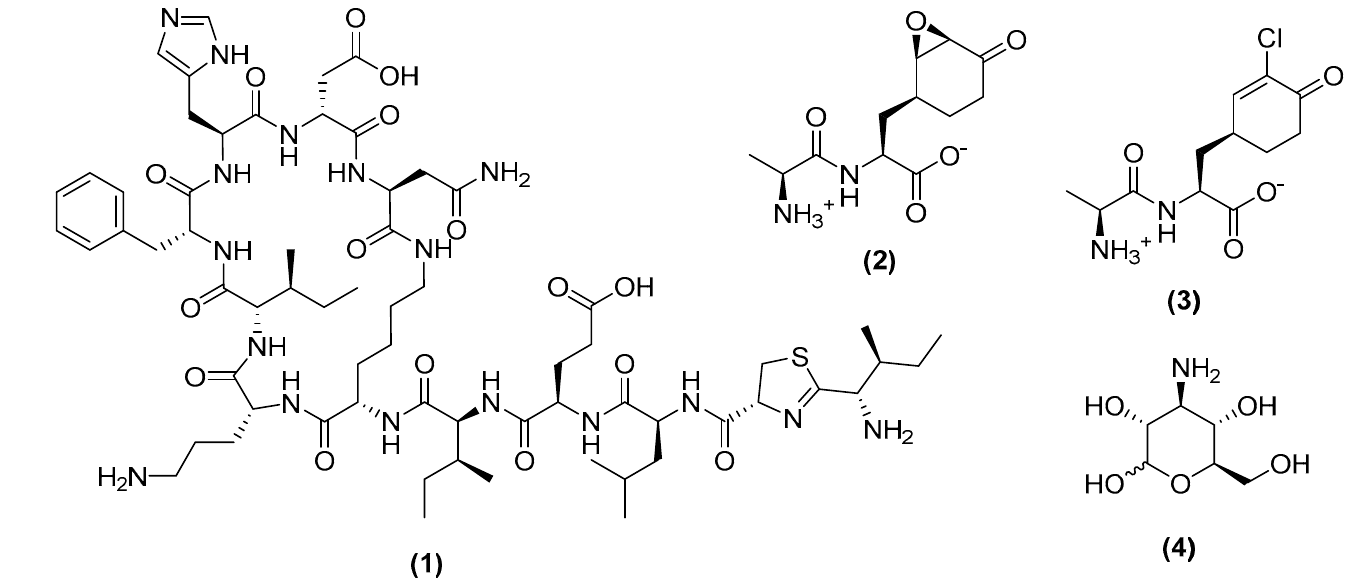
Figure 3. Chemical structures of bacitracin A ( 1 ), bacilysin ( 2 ), chlorotetaine ( 3 ), and kanosamine ( 4 ). Lipid II is a peptidoglycan intermediate, which is formed when the glycosyltransferase MurG catalyzes the addition of N-acetylglucosamine (GlcNAc) to lipid I [25]. Lipid II subse- quently translocates across the plasma membrane, where it transfers MurNaC and GlcNAc to the peptidoglycan layer [26] (Figure 2a). Lipid II is generally conserved throughout microbes and has been studied as a target for various antimicrobial compounds, especially lantibiotics [27]. Lantibiotics are a class of large ribosomal compounds, typically around 3000kDa, and contain unique lanthionine and β -methyllanthionine residues [28]. These lantibiotics are often further divided based on the enzymes involved in their biosynthesis, which includes class I (5, 6) and class II (7, 8, 9) lantibiotics (Figure 4). Subtilin (5) is a class I lantibiotic isolated from B. subtilis 6633 [29]. This metabolite inhibits gram-positive bacteria, with MIC of 0.05 µ g/mL ( Micrococcus luteus NDCO8166) [29]. Binding studies show that subtilin binds to lipid II and pyrophosphate-containing intermediates. These pyrophosphate intermediates coat the outer cell membranes, and subtilin attaches to these intermediates, forming membrane pores [30]. These pores release essential metabolites, which eventually lead to cell death. Clausin (6), a class I lantibiotic produced by B. clausii O/C, inhibits gram-positive microbes (e.g., Micrococcus luteus , MRSA with MICs = 16 mg/L and 128 mg/L respectively) [31,32]. Clausin interacts with both lipid I/II and GlcNAc, form- ing stable complexes, which obstruct its role in peptidoglycan biosynthesis and hindering microbial growth [31].